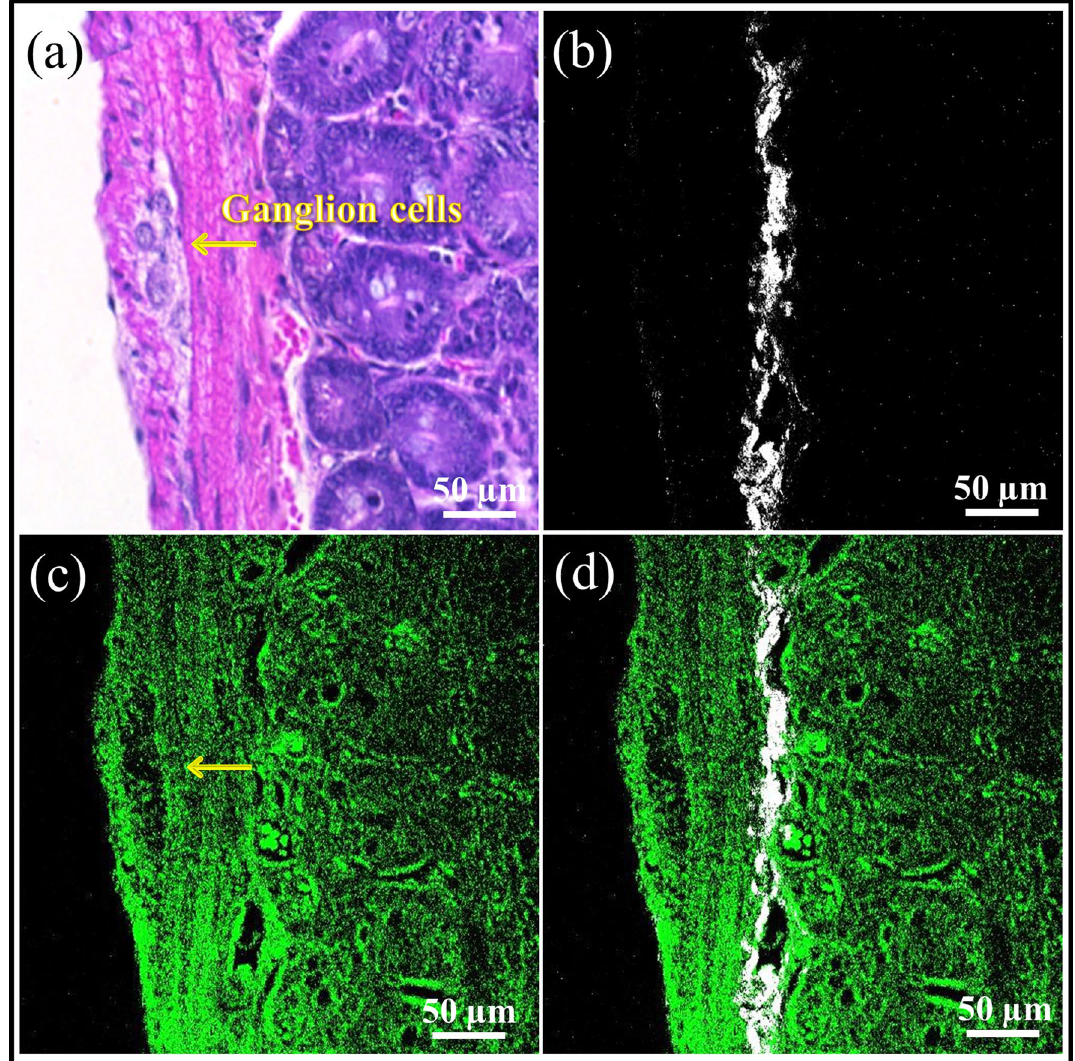
Figure 4. ( a ) Brightfield image from an H&E stained tissue section. Label-free ( b ) SHG, ( c ) 2PAF, and ( d ) overlaid SHG (white) and 2PAF (green) images from an adjacent near-identical